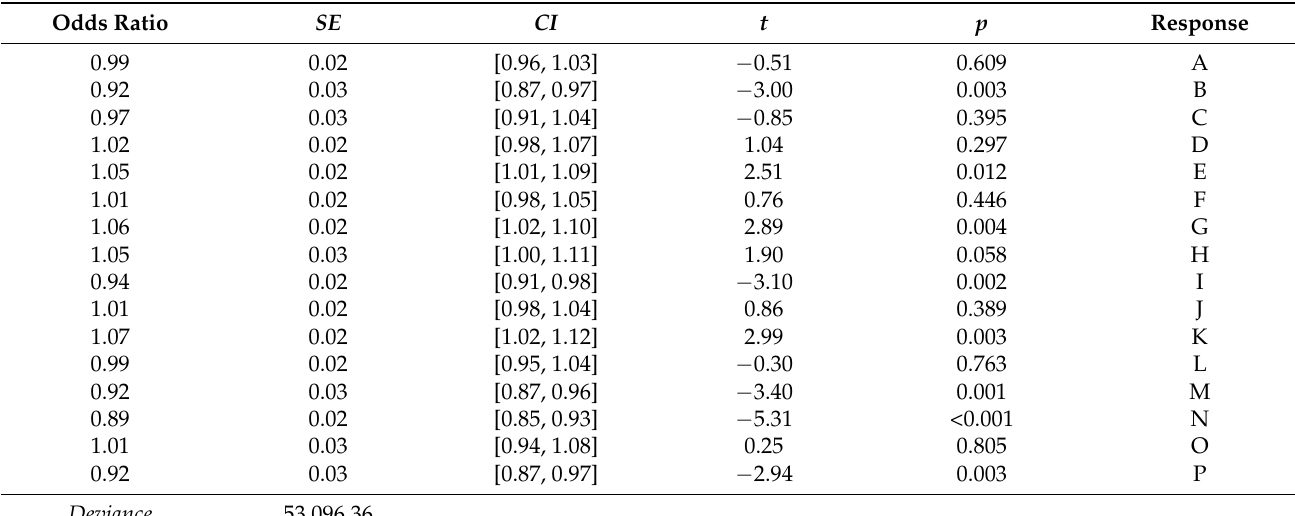
Table A13. Emospace widget response multinomial logistic regression model for agreeableness concerning the space of a widget as